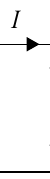
Figure 6. Equivalent circuit diagram of single diode model.